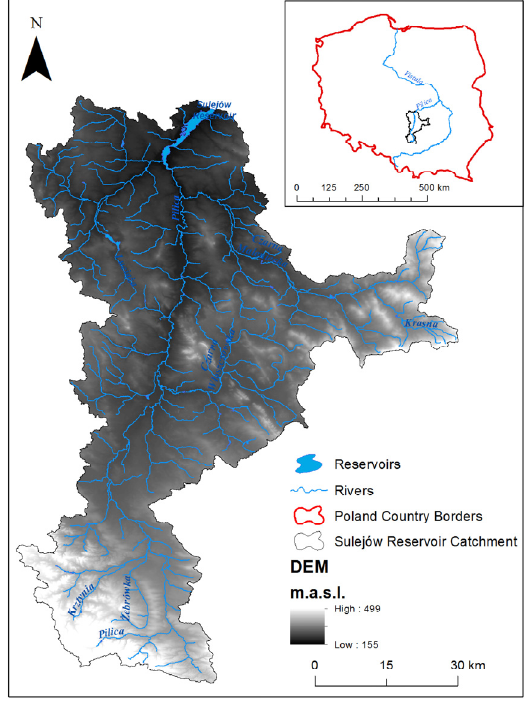
Figure 1. Study area: Sulejów Reservoir Catchment (SRC) and its location in